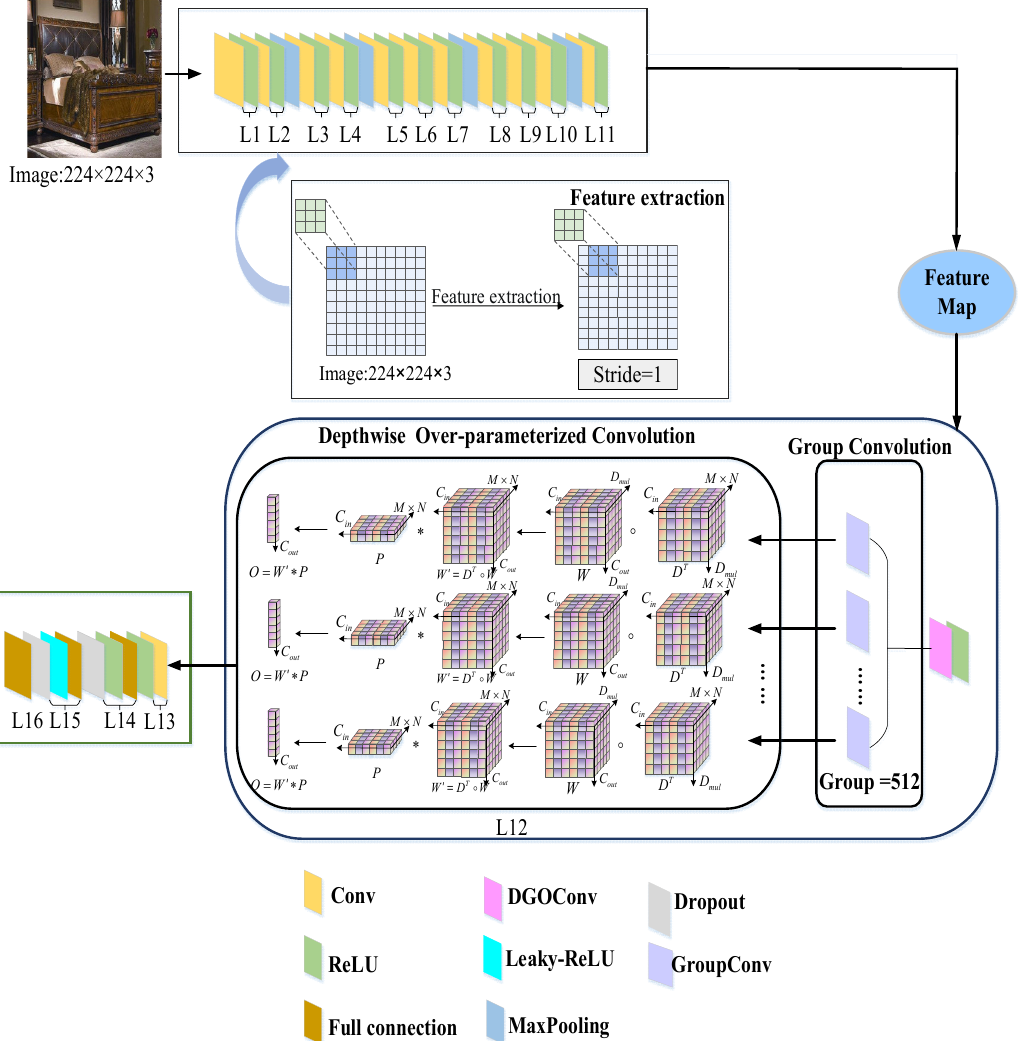
Figure 3. The proposed DGOVGG16 model of furniture image classification.